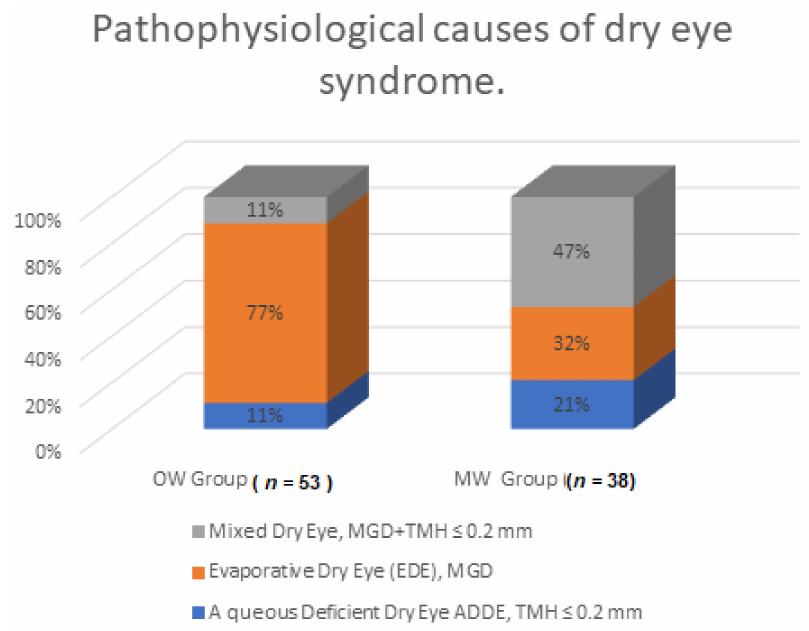
Figure 3. Pathophysiological causes of dry eye syndrome. Table 2. Pathophysiological causes of dry eye